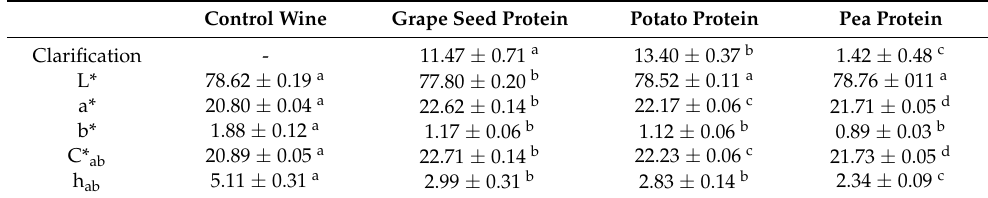
Table 4. Clarification (%, mean ± SD) and chromatic parameters (mean ± SD) of Syrah red wines with pH 3.3 and 11% ( v / v ) ethanol content before (control wine) and after fining treatment with grape seed, potato or pea